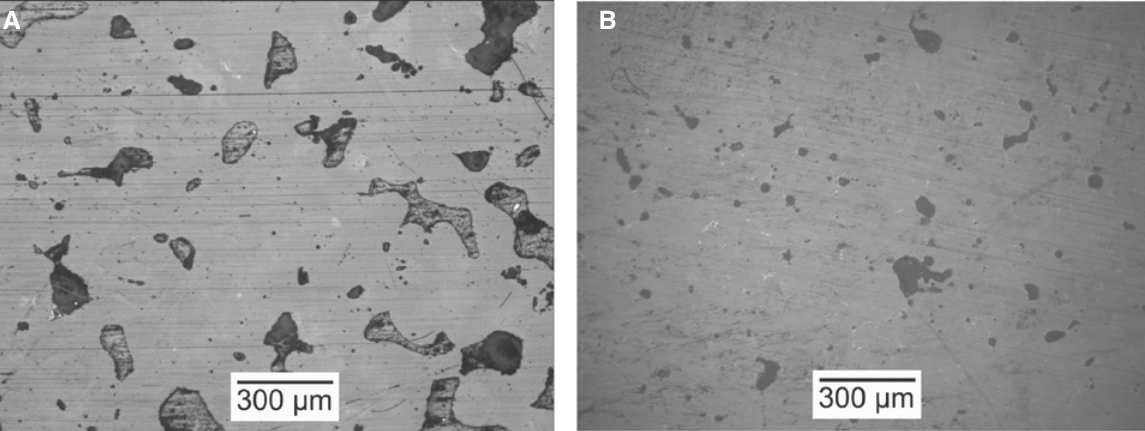
.All samples were sintered at 750 ° C for 30 min. 2